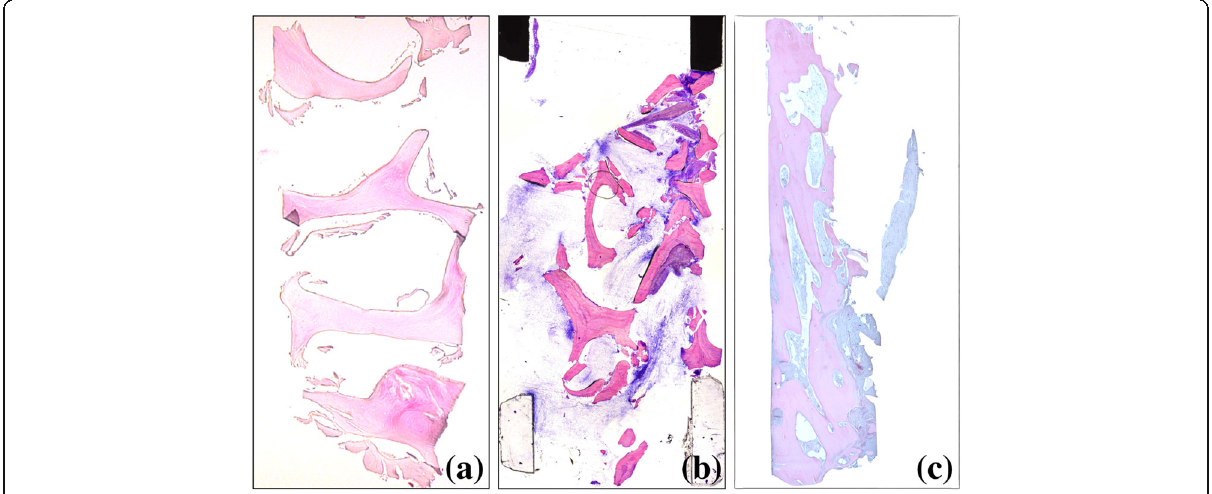
Fig. 4 Histological samples. a CCXBB control without implantation. b Histologic samples with acute inflammatory infiltration. c Histologic sample with limited remaining CCXBB and large bone